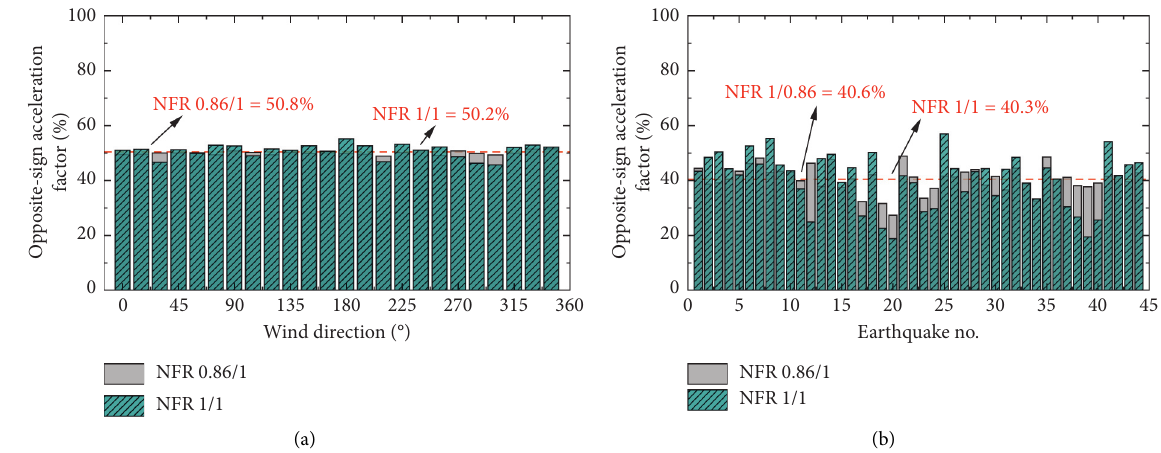
Figure 13: Variation of opposite-sign acceleration factor at 210.2m height under (a) 24 wind directions and (b) 44 earthquake